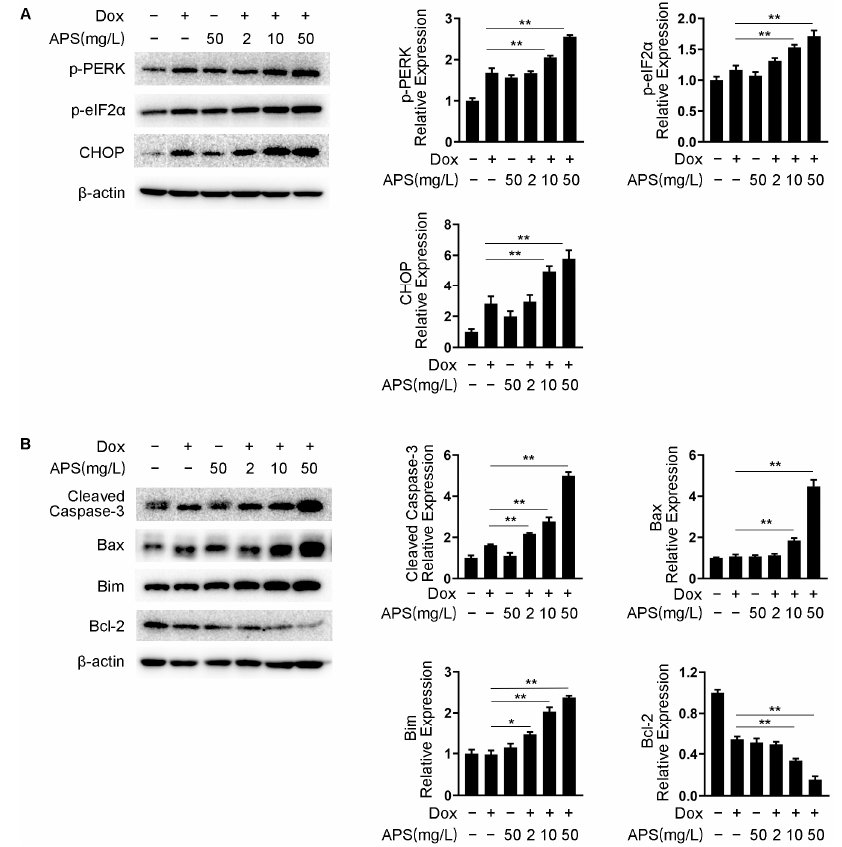
Figure 2. APS induces ER stress response and enhances the Dox-induced apoptosis in Hep3B cells. Hep3B cells were treated with 1 µ M Dox along with or without increasing doses of APS (2, 10, 50 mg/L). ( A ) ER stress-responsive proteins were examined using Western blots. ( B ) Apoptosis-related proteins were examined using Western blots. Data are expressed as mean ± SEM from three independent experiments. *, p < 0.05, **, p <